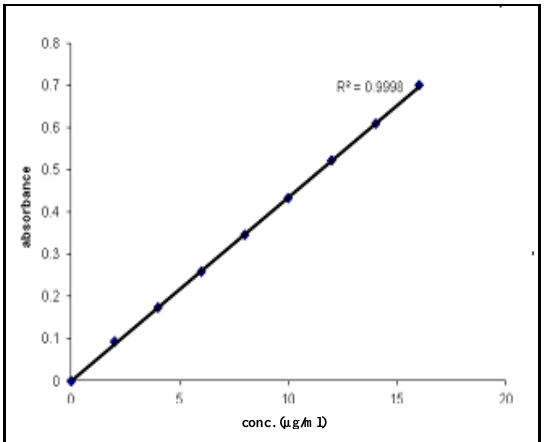
Figure 1: Calibration curve of Bisoprolol in distilled water